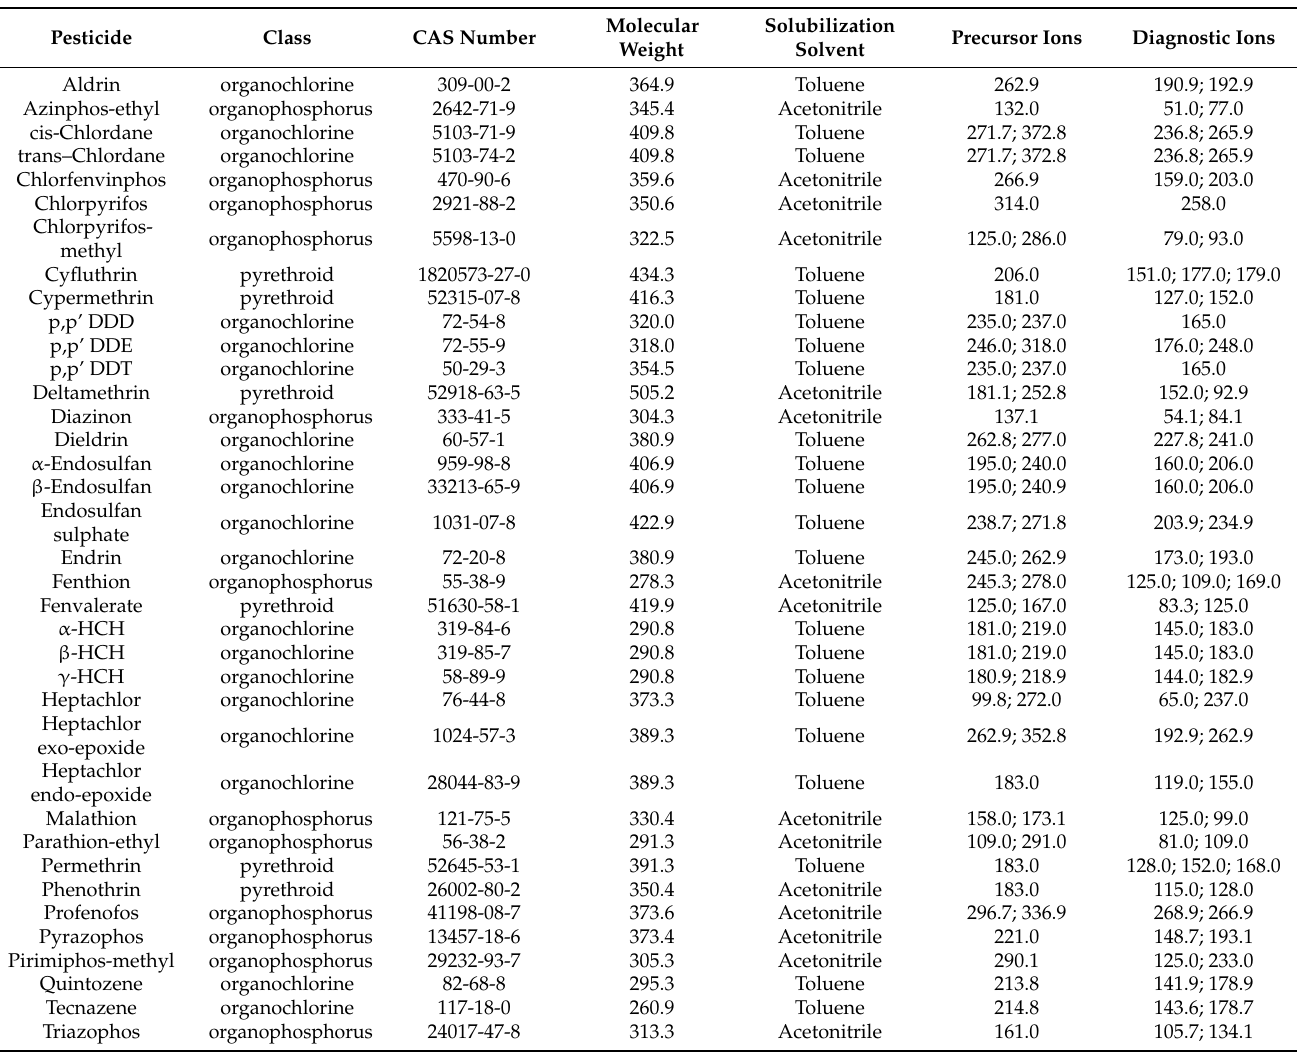
Table 1. List of pesticides analyzed by